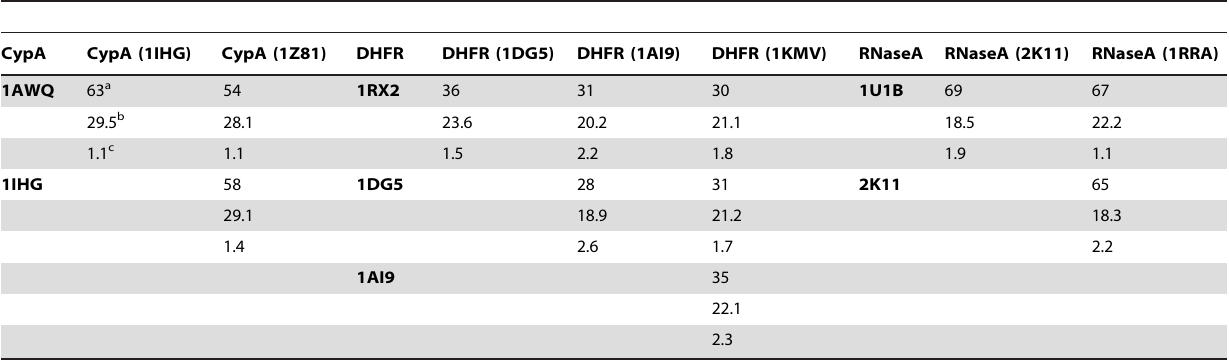
Table 6. Sequence and structural comparison of the enzymes